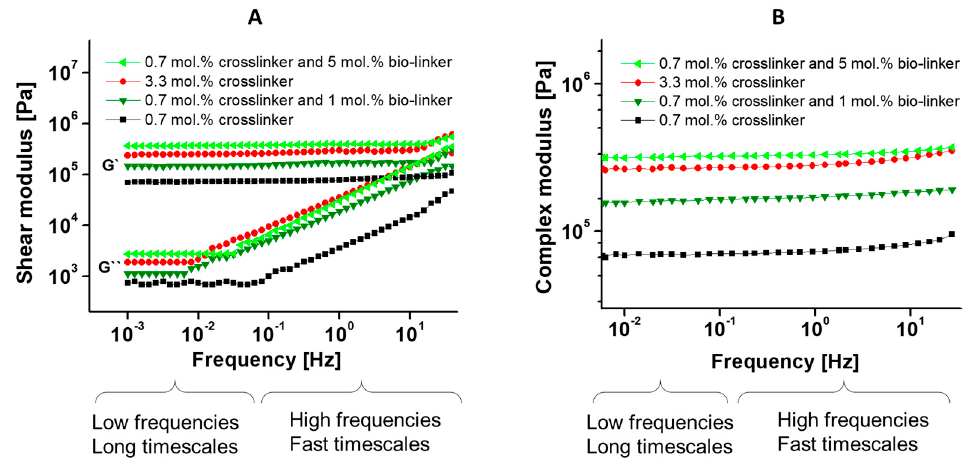
Figure 1. Repeated frequency dependence measurements of ( A ) storage (G´) and loss (G´´) moduli and ( B ) complex modulus (G*) in Pa at 25 °C for the synthesized hydrogels with different percentages of cross-linker and bio-linker ( 3 ). As controls, the gels were also prepared without the bio-linker ( 3 ), with just the crosslinker, and with included bio-linker ( 3 ). The moduli were calculated from the mean value of three different samples each.